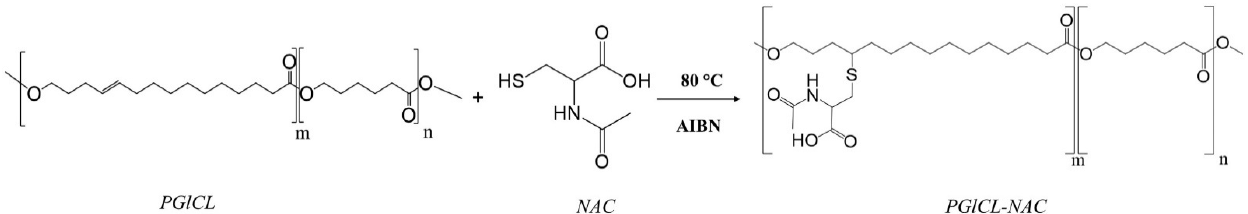
Figure 11. The functionalization of Poly(globalide- co - ε -caprolactone) side-chain with N-acetylcysteine via a thiol-ene re- action as depicted by Guindani et al. Reprinted with permission from [77]; published by Elsevier,